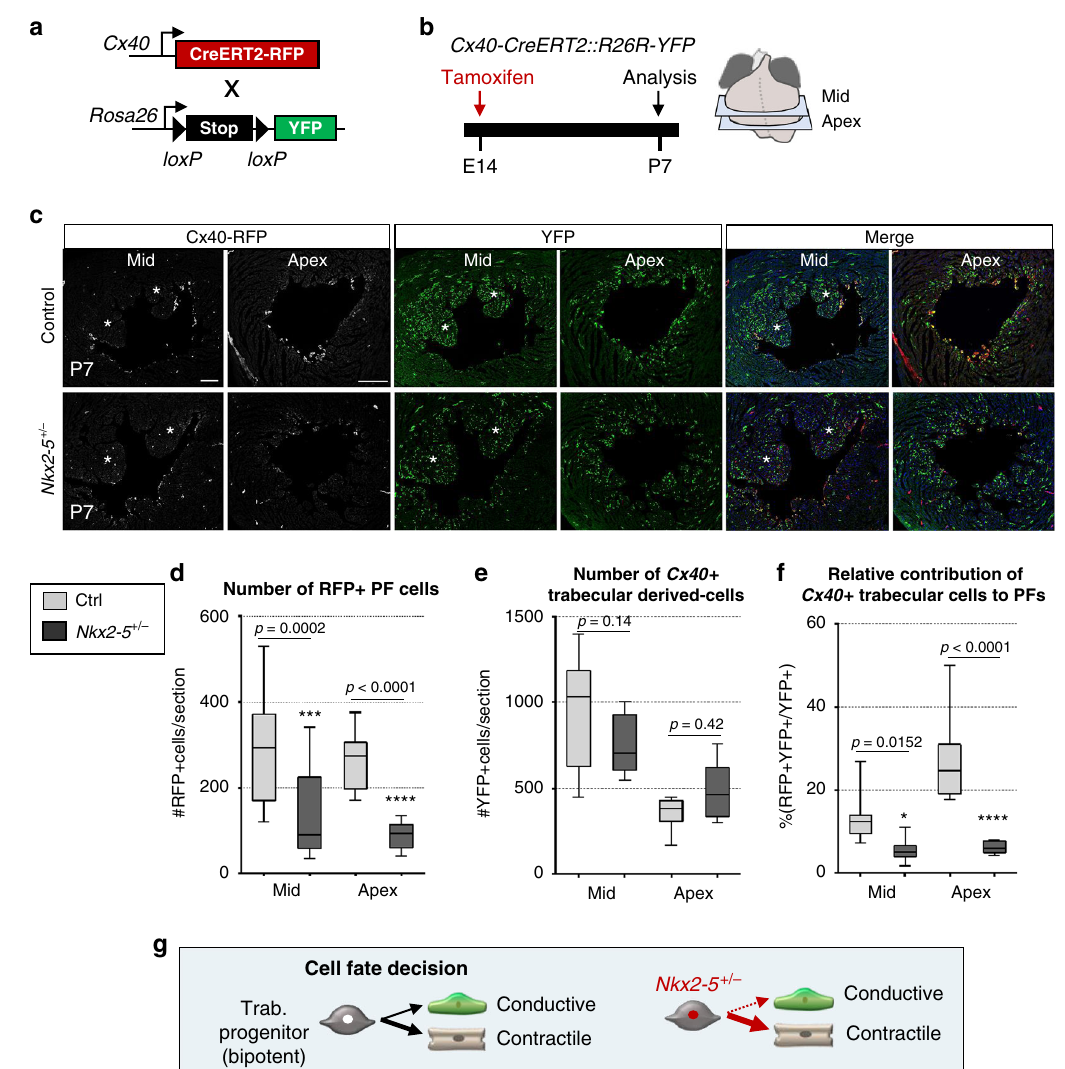
Fig. 1 Defective contribution of Cx40 + derived trabecular cells to the postnatal PF in Nkx2-5 + / − mice. a Scheme of the strategy used for genetic lineage tracing of Cx40 + cells. R26R-YFP reporter mouse line are crossed with tamoxifen inducible Cx40-CreERT2 mice. Injection of tamoxifen induces the recombination of loxP sites resulting in the expression of the fl uorescent protein YFP in Cx40 + cells. b Tamoxifen is injected at E14 and Cx40 + derivative cells are analyzed at P7. c Immunostaining for YFP and RFP on Cx40-CreERT2-RFP::R26R-YFP control (ctrl) or Nkx2-5 + / − heart transverse sections at P7, shows distribution of Cx40 + derivative cells (YFP + ) and their fate into PFs (YFP + RFP + ). Asterisks represent papillary muscles; scale bars = 200 µ m. ( n = 4 Ctrl and Nkx2-5 + / − ). d – f Graphs of quanti fi cations from c images. The total number PF cells (RFP + ) per section d , the total number of trabecular-derived cells (YFP + ) e , and the relative contribution of trabecular cells to PFs ((YFP + RFP + )/YFP + ) f are quanti fi ed in mid and apical sections. Box plots show the median, the 25th and 75th percentile, and the whiskers denote the minimum and maximum values, respectively. Mean of 3 sections/heart; ( n = 4 Ctrl and Nkx2-5 + / − ). P values are derived ordinary one-way ANOVA test, * P < 0.05; *** P < 0.001. g Scheme illustrating the differentiation of embryonic trabecular progenitors into conductive and contractile cardiomyocytes. In Nkx2-5 + / − mice, the cell fate decision into conductive cardiomyocytes is disturbed and haploinsuf fi cient trabecular progenitors mostly give rise to contractile